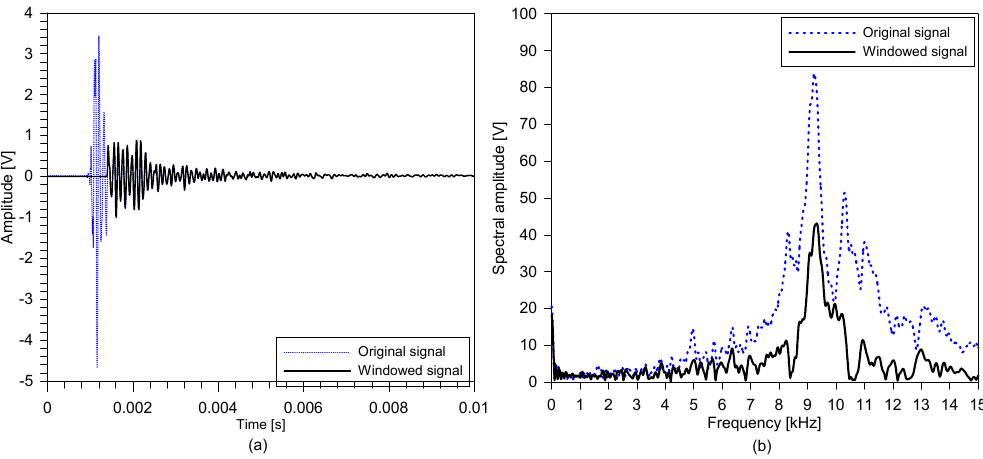
Figure 8. Typical signals from the IE testing of the sound concrete slab specimen: ( a ) typical time signal and ( b ) spectral amplitude signal.